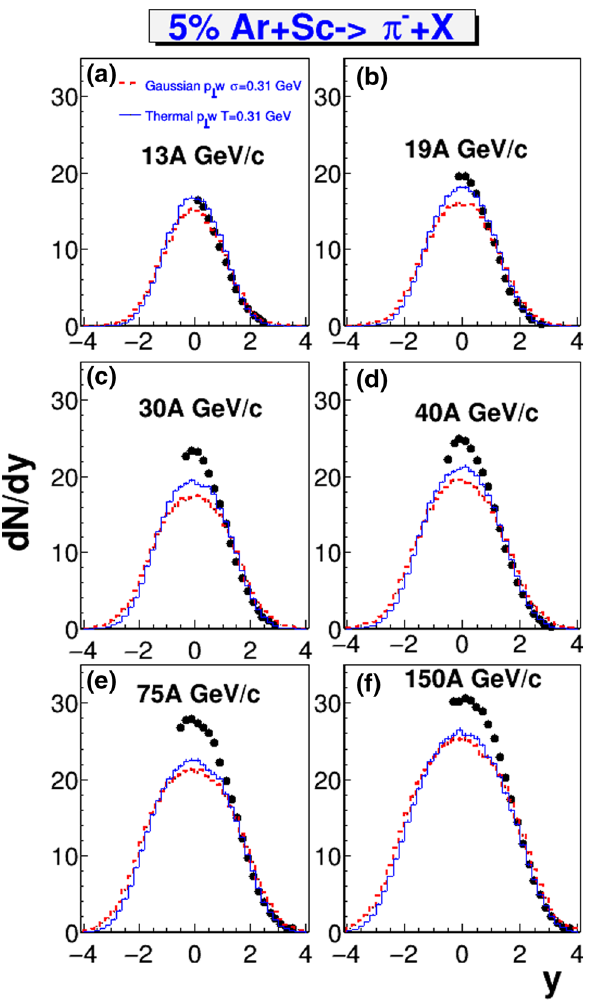
Fig. 9 Same as Fig. 8, but here the lines denote the Gaussian and ther- mal calculations with primary hadron rescatterings (HadRSc) included π − obtains larger m T values due to expansion flow. It